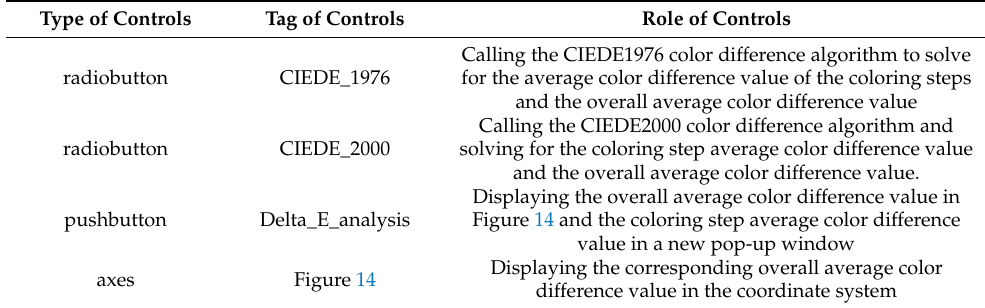
Table 4. Types, labels and roles of controls used in the Module 4 interface.